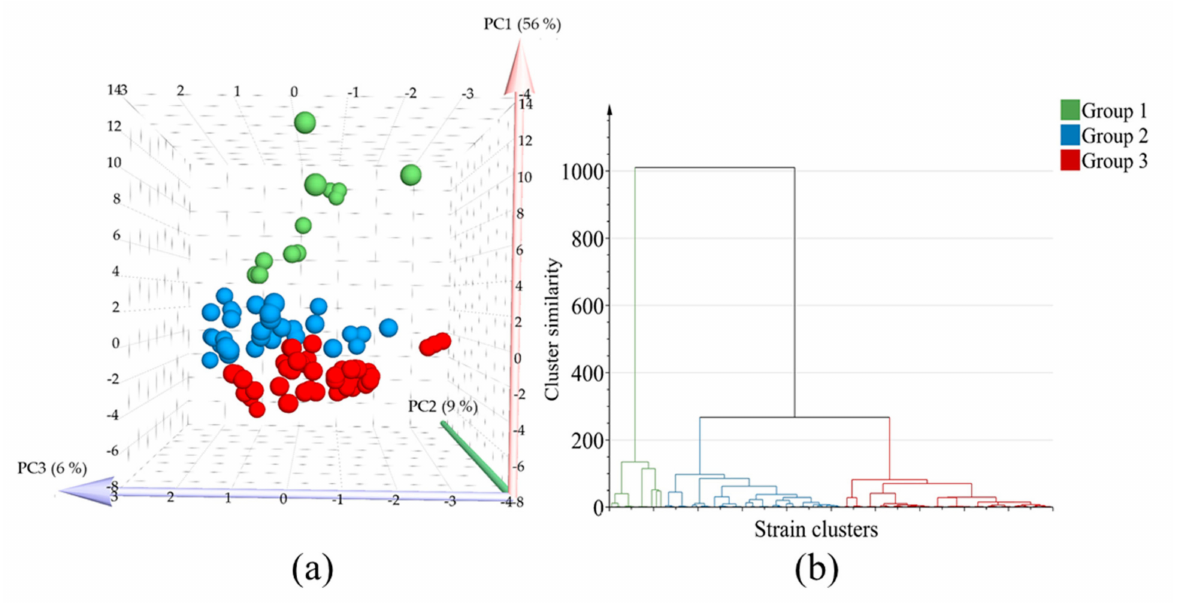
Figure 2. Multivariate data analysis using high performance thin layer chromatography (HPTLC) analysis data of methanol extracts of fungal endophytes grown on potato dextrose agar. ( a ), Score plot of principal component analysis using PC1, PC2 and PC3, in which three groups based on hierarchical cluster analysis (HCA) were marked with blue, green and red colors. ( b ), hierarchical cluster analysis using 18 principal components. X axis is conformed of strain names clustered by HCA and Y axis indicates the loss in within cluster similarity, that is, variance increase when clusters are merged. Thus Y axis is dimensionless.